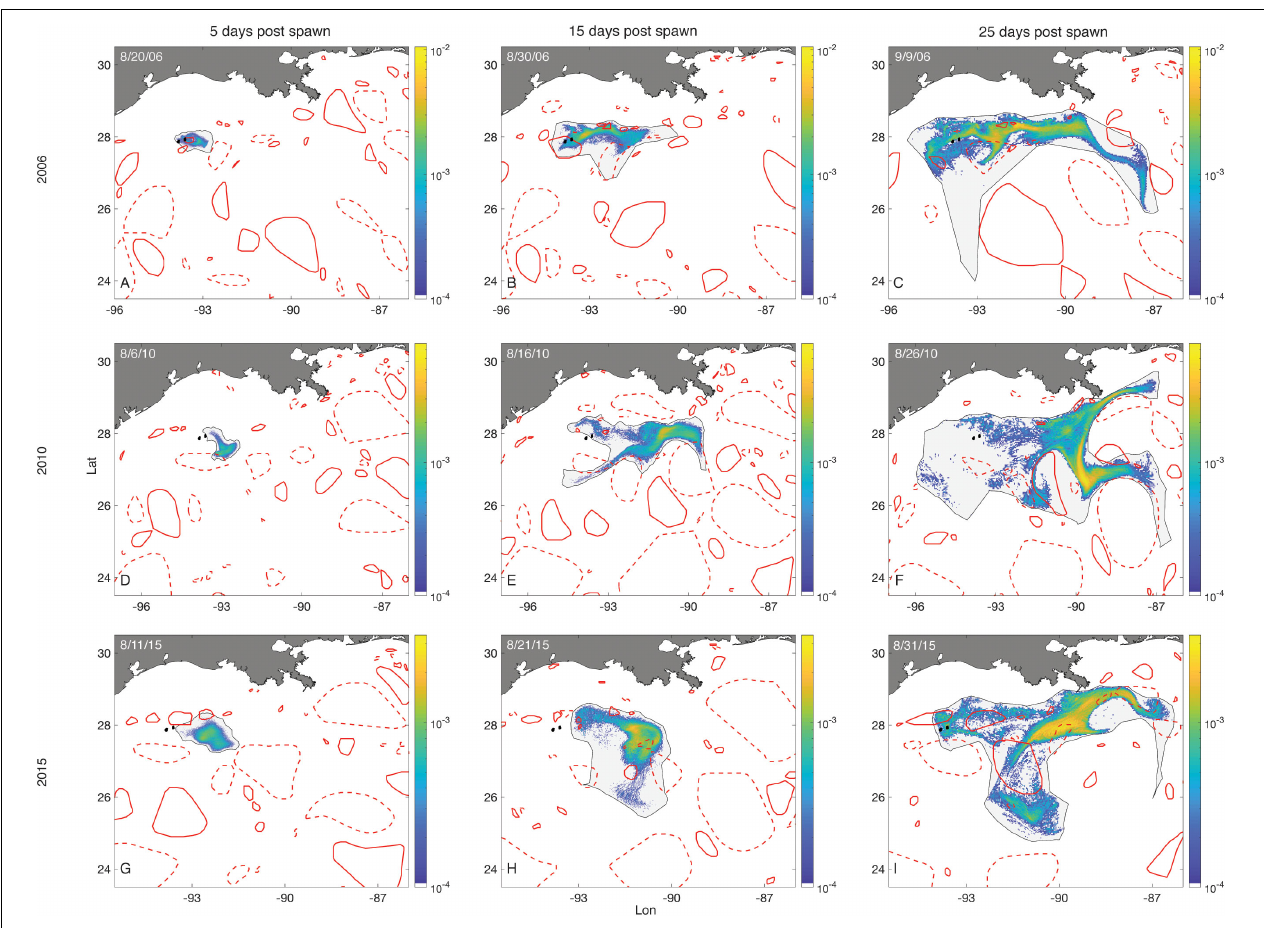
FIGURE 8 | Larval distributions– O. faveolata . Plots show larval distributions as probability density surfaces bounded by non-convex hulls following three 3-day spawning events (rows). The first column shows the distribution of larvae on the fifth day after the start of spawning, representative of the first full day in which all larvae were competent. The next two columns show distributions of those larvae 15 and 25 days into their dispersal windows. Density is scaled to the maximum single cell value within a spawning event. The FGB sanctuary boundaries are shown as black filled polygons. Eddies are represented by red empty polygons. Solid lines are cyclonic eddies and dashed lines are anticyclonic